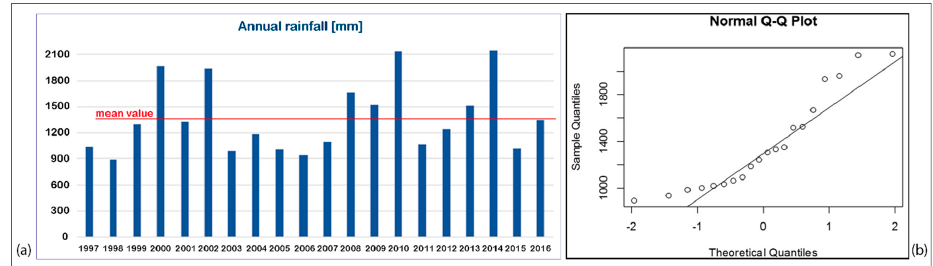
Figure 10. 20 years of available rainfall data ( a ) and a comparison between the rainfall distribution and the Gaussian one ( b ).